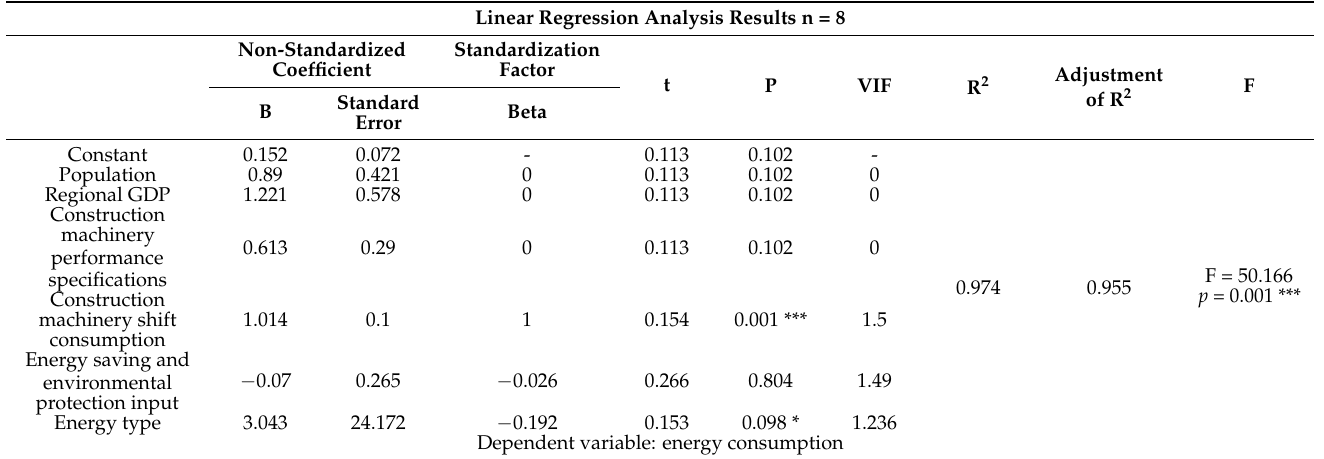
Table 7. Results of multiple regression analysis of energy consumption.